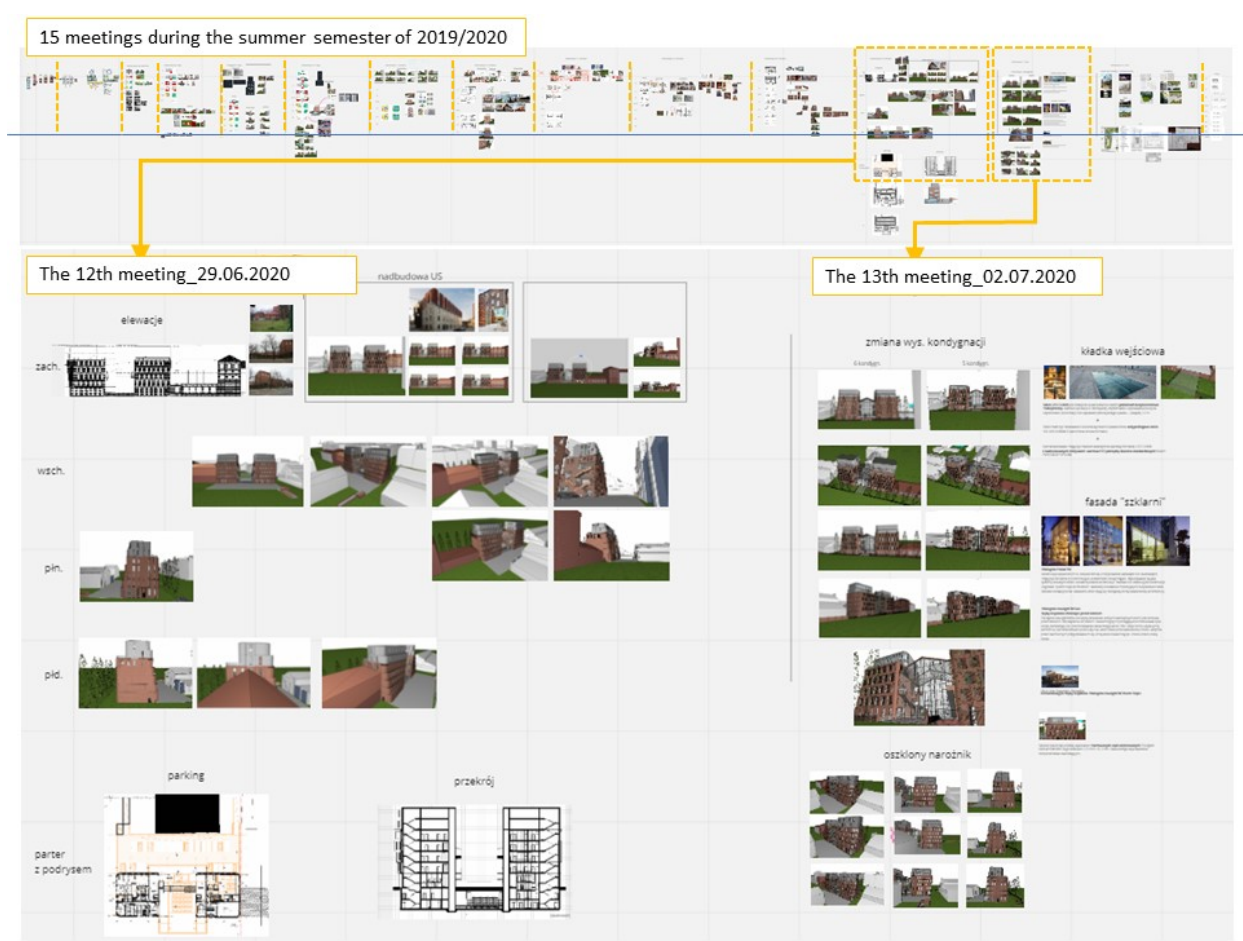
Figure 4. Project Journal (Student E-portfolio)—a sample Miro collaborative board presenting student’s work through the whole semester (above). Close-up of the same board presenting results of two online meetings/consultations with the instructor (lower row).